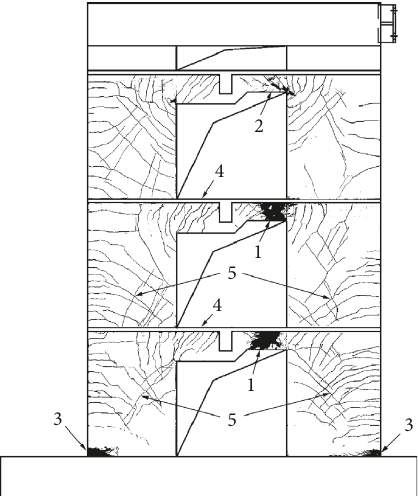
Figure 9: Distribution of the cracks (numbers represent crack order).